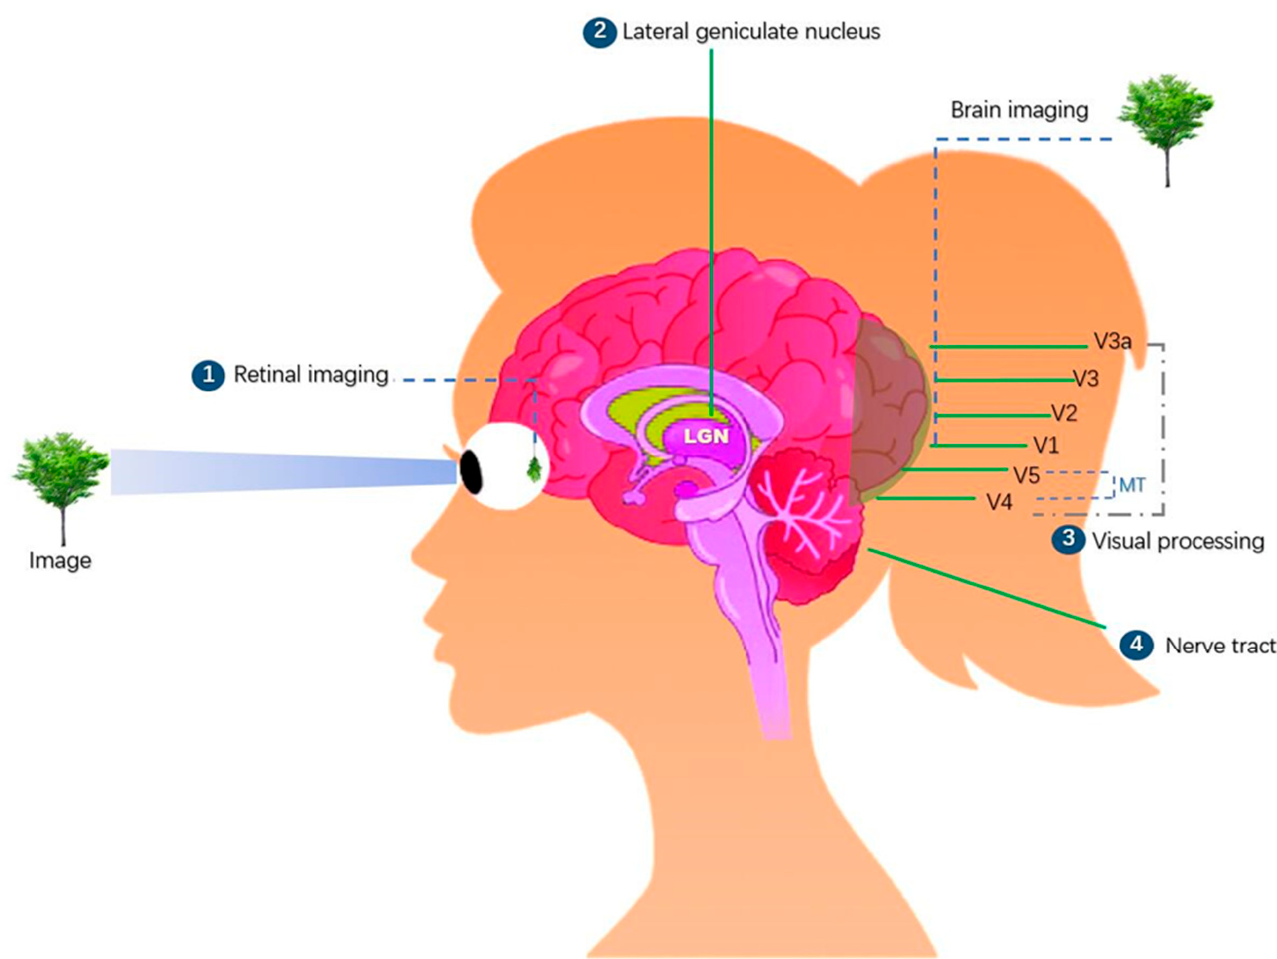
Figure 1. In the human visual system, “Retinal imaging” ( ① ) is the first stage for processing an image when it enters the eye’s visual field. The retina transmits pixels, shade, and color through the chiasma to the brain stem’s “lateral geniculate nucleus” (LGN) ( ② ). Visual information is further processed here, important visual information is extracted, useless information is discarded, and critical visual information is processed and transmitted to the primary “visual cortex” ( ③ )V1 and then via V2 and V3 to V4, V5 (MT area), and higher brain areas [48,49]. The visual flow is then processed layer by layer and transmitted to more areas on the surface of the brain, where the brain identifies the object in the eye’s view [50]. The “nerve tract” ( ④ ) runs through the brain and spinal cord throughout the body, and its main function is to control body movement [51].